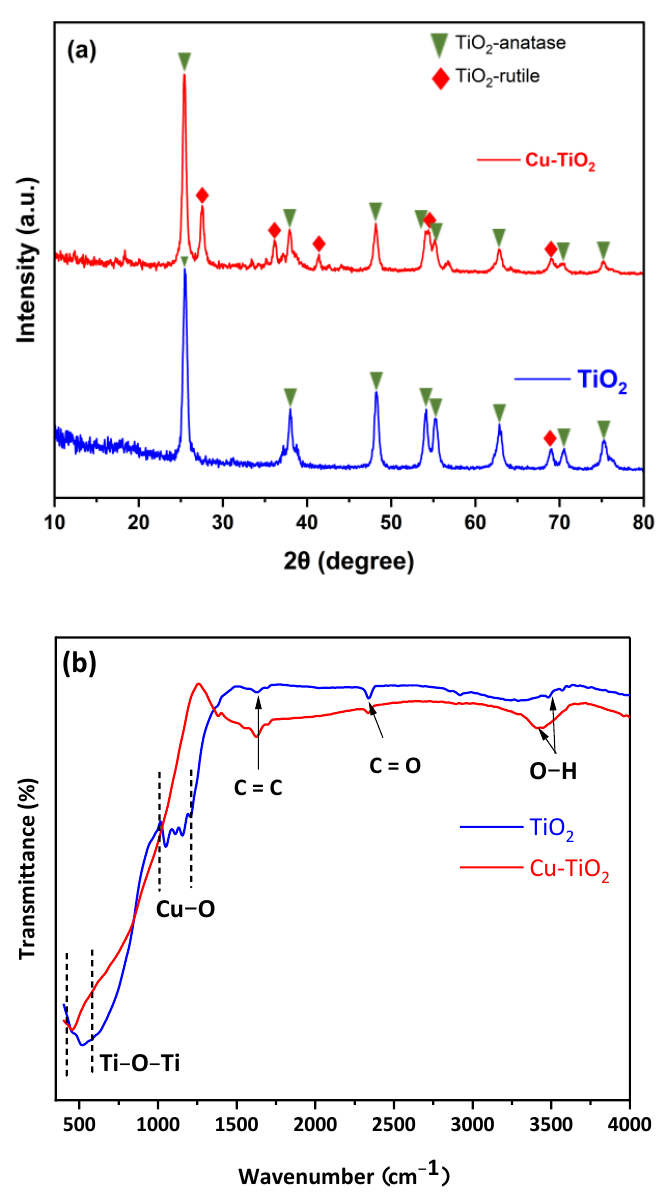
Figure 1. XRD images ( a ) and FTIR patterns ( b ) of pure TiO 2 and as-made Cu-TiO 2 . The FTIR spectra of TiO 2 and Cu-TiO 2 are displayed in Figure 1b. The FTIR spectrum of the catalyst shows absorption peaks between 400 and 600 cm − 1 , which is ascribed to Ti-O-Ti stretching. In addition, other peaks of about 1623 and 2347 cm − 1 are related to C = C and C = O functional groups, respectively. The medium peaks at about 3485 and 3500 cm − 1 confirm the presence of OH bands in the sample structure due to surface adsorb water and hydroxyl agent. The vibration bands are observed between 1000 to 1250 cm − 1 after Cu-doped TiO 2 indicated lattice vibration of TiO 2